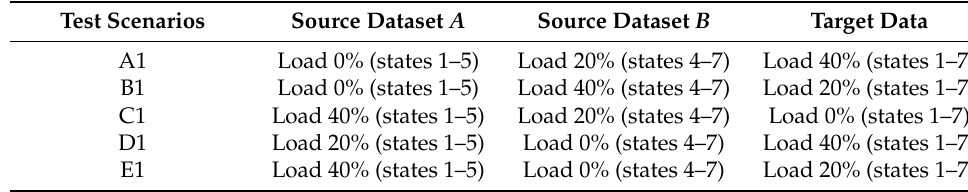
Table 5. Five different test scenarios.